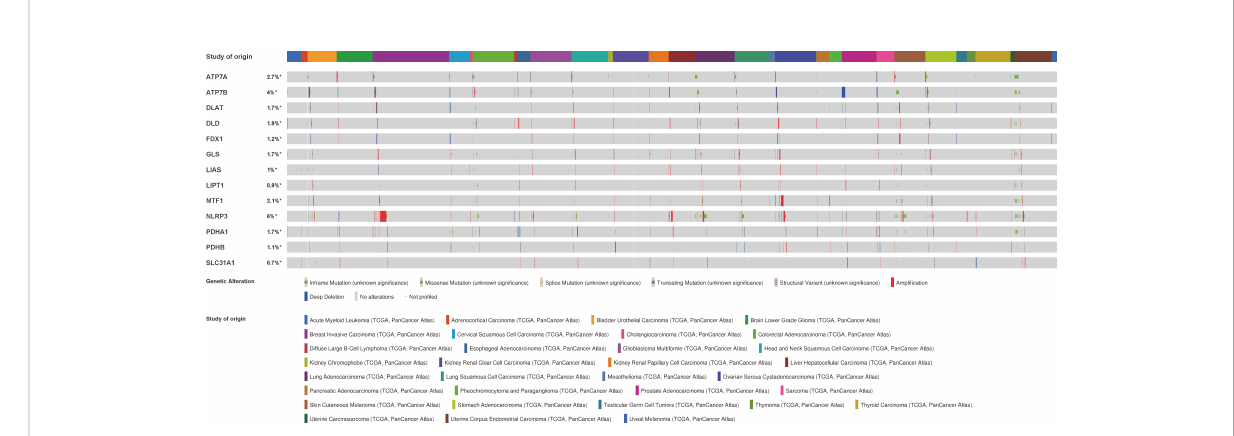
FIGURE 5 The genetic alteration characteristics of cuproptosis-related genes across different tumors